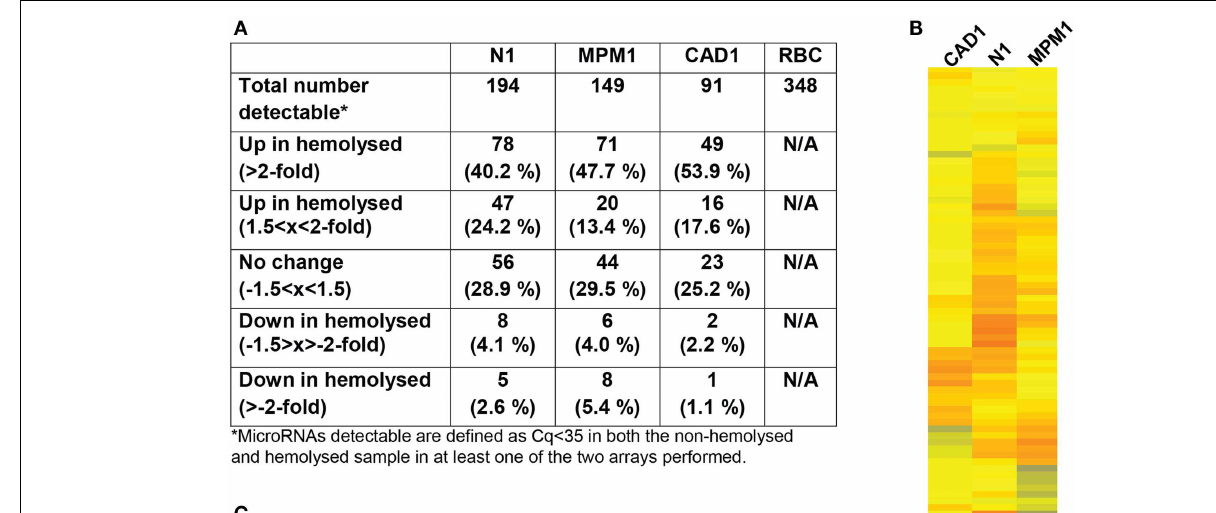
level (non-hemolyzed = 0), with ± 3.3 being the equivalent of a ± 10-fold difference in relative abundance.The microRNAs presented are those detectable in at least four out of the six plasma samples investigated. (C) Overlap of microRNAs increased > 2-fold in each of the three pairs. Fifteen microRNAs (inner triangle) were > 2-fold increased in all three investigated pairs, and an additional 37 microRNAs were > 2-fold increased in at least two of the investigated